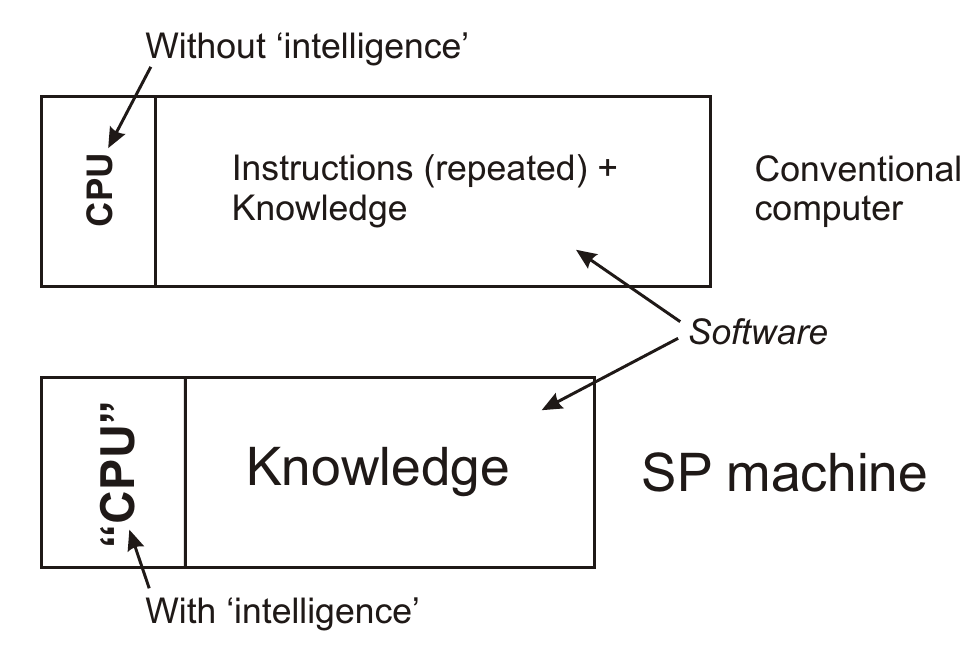
Figure 3. Schematic representations of a conventional computer and an SP machine, as discussed in the text. Adapted with permission from Figure 4.7 in